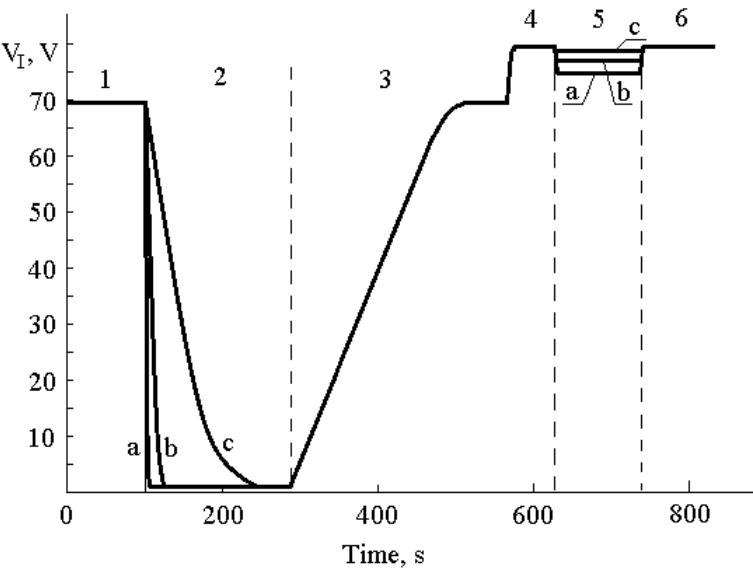
Figure 4. Time dependence of voltage across the MOS structure when constant current of different densities flows through dielectric: 1,2,3—10 − 8 A / cm 2 ; 4,5,6—10 − 6 A / cm 2 ; for Sections 2 and 5 we realized irradiation by α -particles when the radiation source was in varying distances from the MOS sensor: a —4 mm; b —15 mm; c —30 mm.